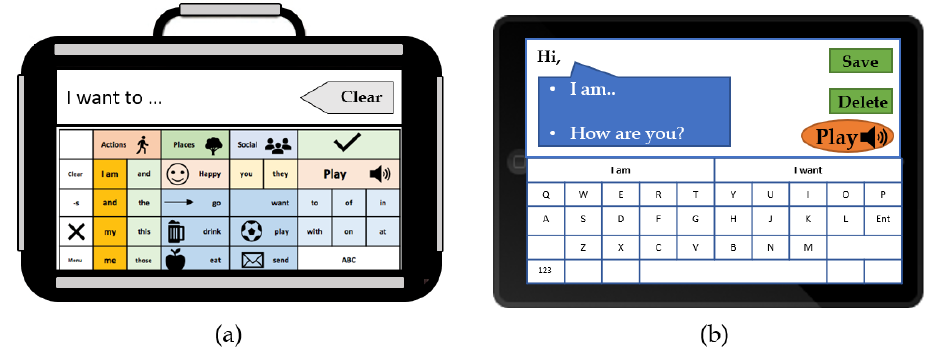
Figure 4. Examples of ( a ) a dedicated touch-based device and ( b ) a non-dedicated smart device running an AAC application (APP), usually with predictive language model and speech generation capabilities.